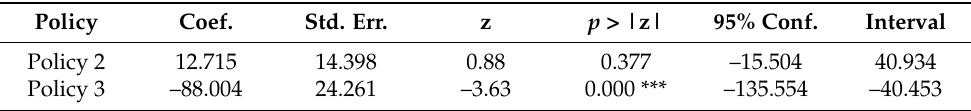
Table 4. Results of the RD method of pollutant concentration on restriction days.